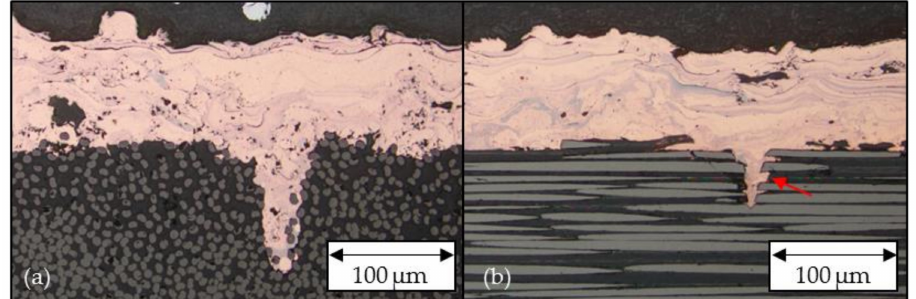
Figure 8. Cross-sections perpendicular ( a ) and parallel ( b ) to fiber orientation of wire arc copper coated laser-structured (R+GS_300_100) CFRP; red arrow indicates fine undercuts filled by coat- ing material.